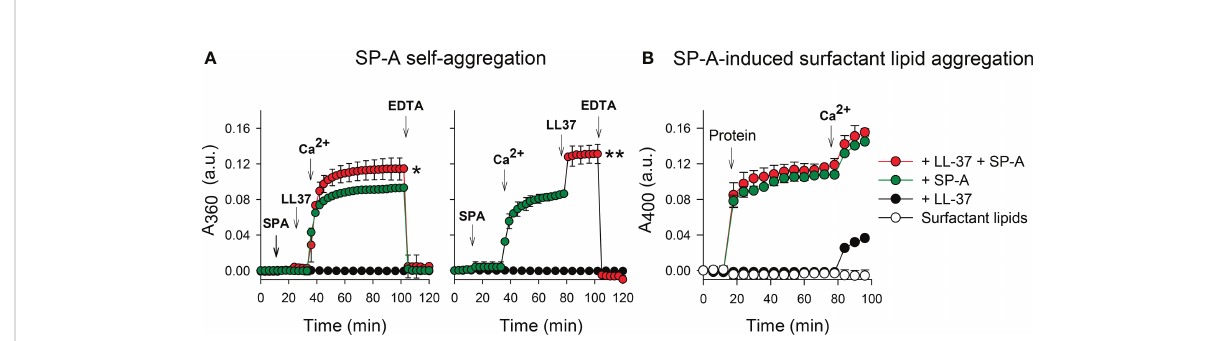
FIGURE 5 Effects of LL-37 on Ca 2+ -dependent properties of SP-A. (A) The effect of LL-37 on the kinetic of self-aggregation of SP-A was determined by measuring the change in turbidity at 360 nm. The sample and reference cuvettes were fi lled with 5 mM Tris-HCl buffer (pH 7.4), and after 10 min equilibration at 37°C, SP-A (75 nM, 50 µg/ml) was added. The absorbance change at 360 nm was monitored at 37°C at 1 min intervals. LL-37 (1.1 µM) was added to the solution containing SP-A (o buffer) before (left) or after (right) addition of 5 mM Ca 2+ ( fi nal concentration). Self-aggregation was reverted by EDTA (10 mM, fi nal concentration). (B) The effect of LL-37 on surfactant lipid aggregation induced by SP-A was determined by measuring the change in turbidity at 400 nm. Sample and reference cuvettes were fi rst fi lled with 80 m g/ml surfactant-like vesicles composed of DPPC/POPG/PA (23:10:1.6, w/w/w) in 5 mM Tris-HCl buffer, pH 7.4, containing 150 mM NaCl. After a 10-min equilibration at 37°C, SP-A (50 m g/mL), LL-37 (1.1 µM), or SP-A+ LL-37 were added to the sample cuvette, and the change in absorbance at 400 nm was monitored. Next, CaCl 2 (2.5 mM) was added to both sample and reference cuvettes. Control experiments were performed adding buffer instead of proteins to the lipid vesicle suspension in the cuvette. In (A, B) , results are shown as means ± SD of three independent experiments. For statistical analysis, Student ’ s T-test was used. * p < 0.05 and ** p < 0.01 when self-aggregation of SP-A+LL-37 was compared with that of